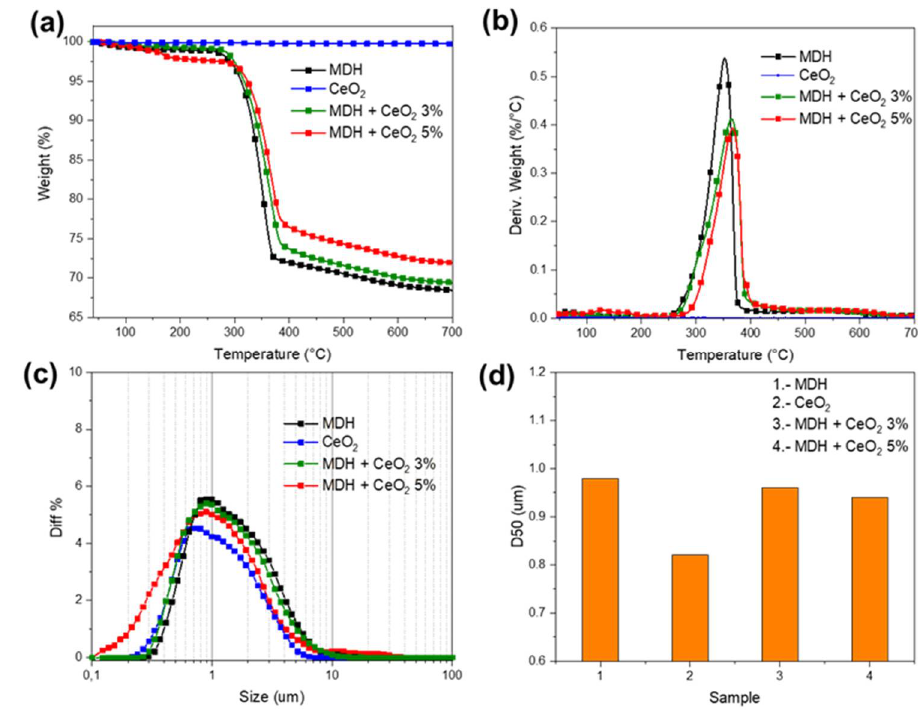
Figure 1. ( a ) TGA ( b ) DTGA ( c ) PSA ( d ) D50 of the flame-retardant fillers. Table 3. PSA Results of the Pure and Modified